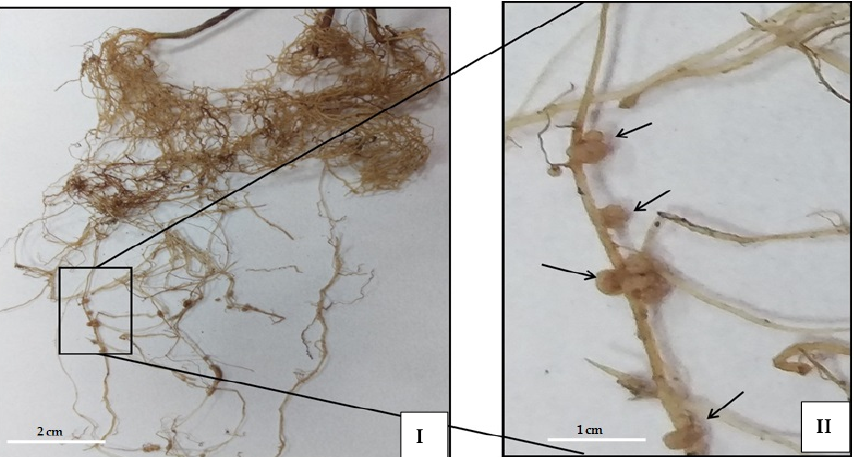
Figure 4. Root nodules at 0.05% ANE treatment in pot root application (PRA) experiment of V. aconitifolia. Scale bar is showing 2cm for ( I ), and 1.0 cm ( II ). 2.5. Effect in Pot Foliar Application (PFA) and Pot Root Application (PRA) of ANE on Biomass